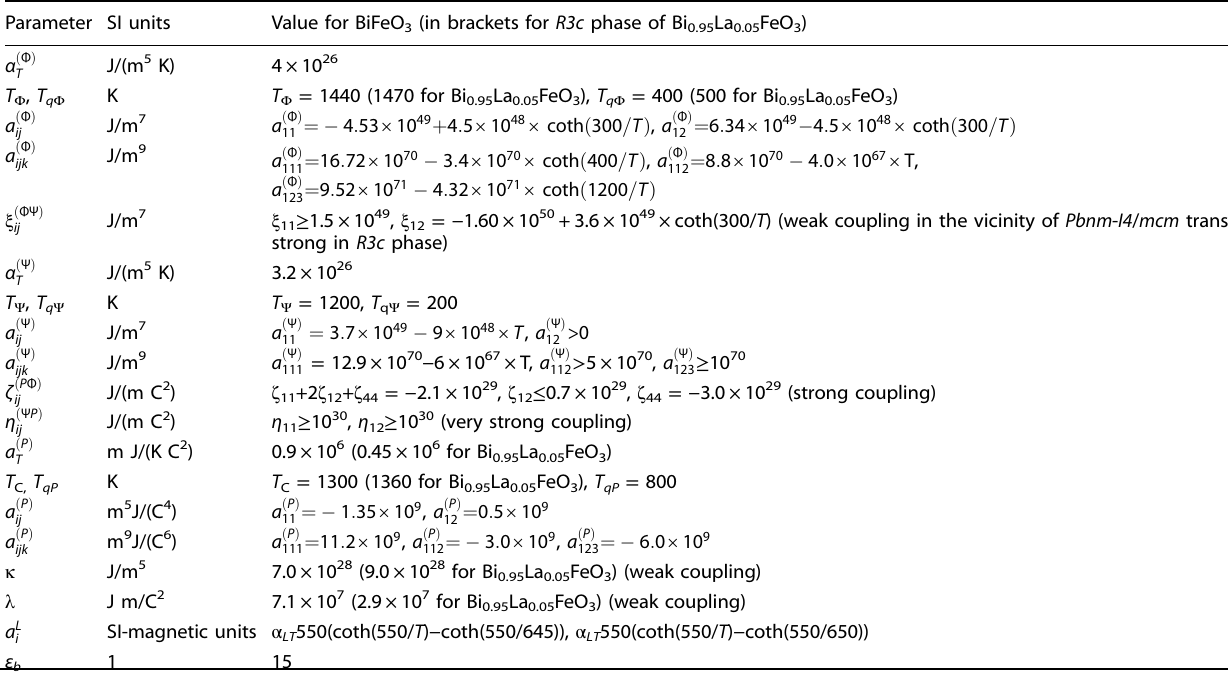
Table 2. Extracted from the fi tting expansion coef fi cients of the LG potential for BiFeO 3 and Bi 0.95 La 0.05 FeO 3 Parameter SI